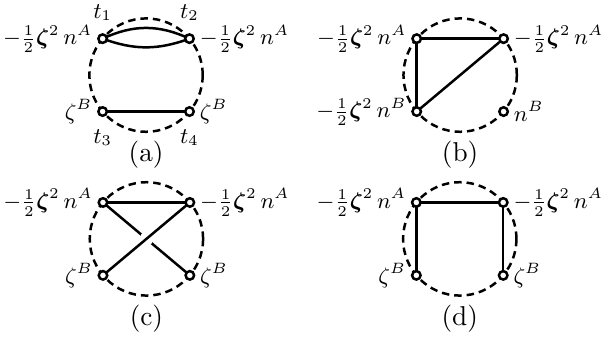
Figure 12 . Tree-level diagrams (and similar ones obtained by permutations) contributing to (G.12). is conformally